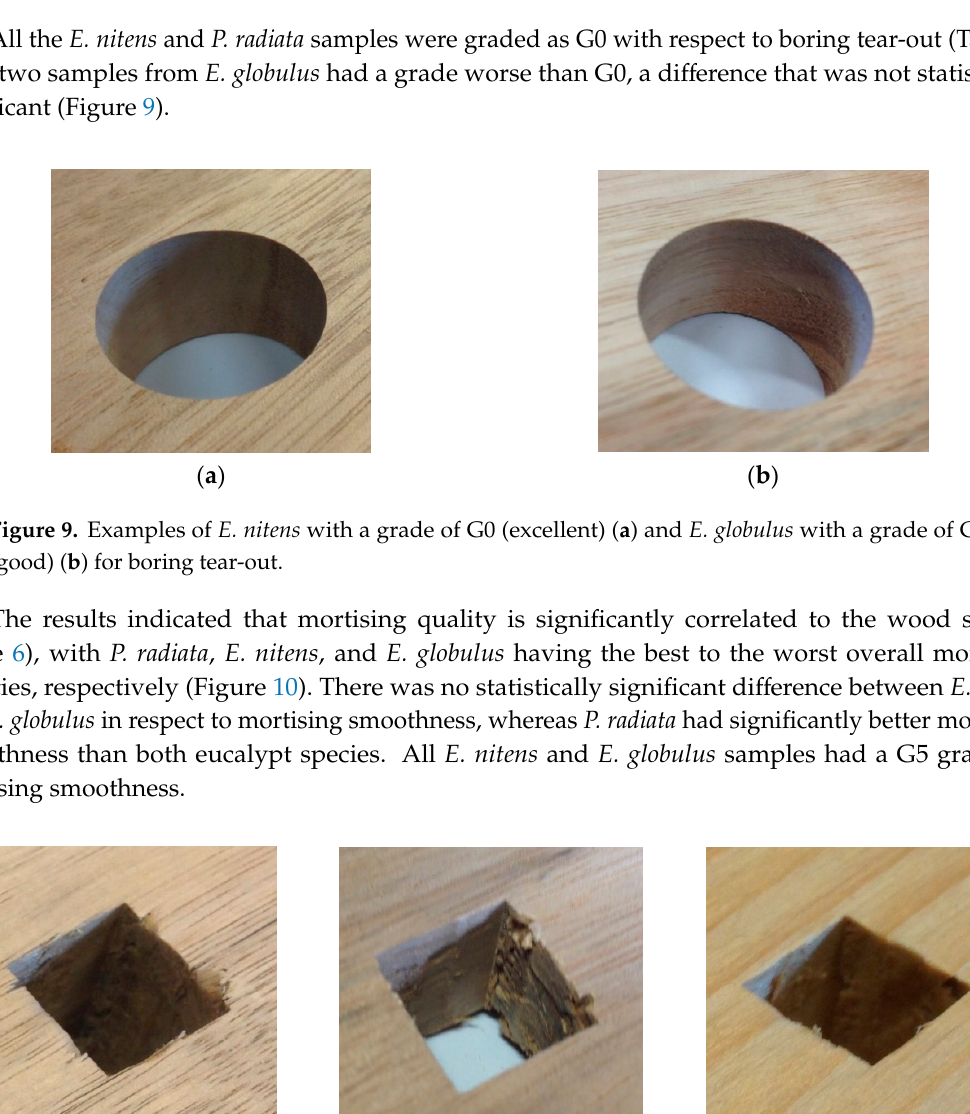
Table 5. Grading results according to boring.